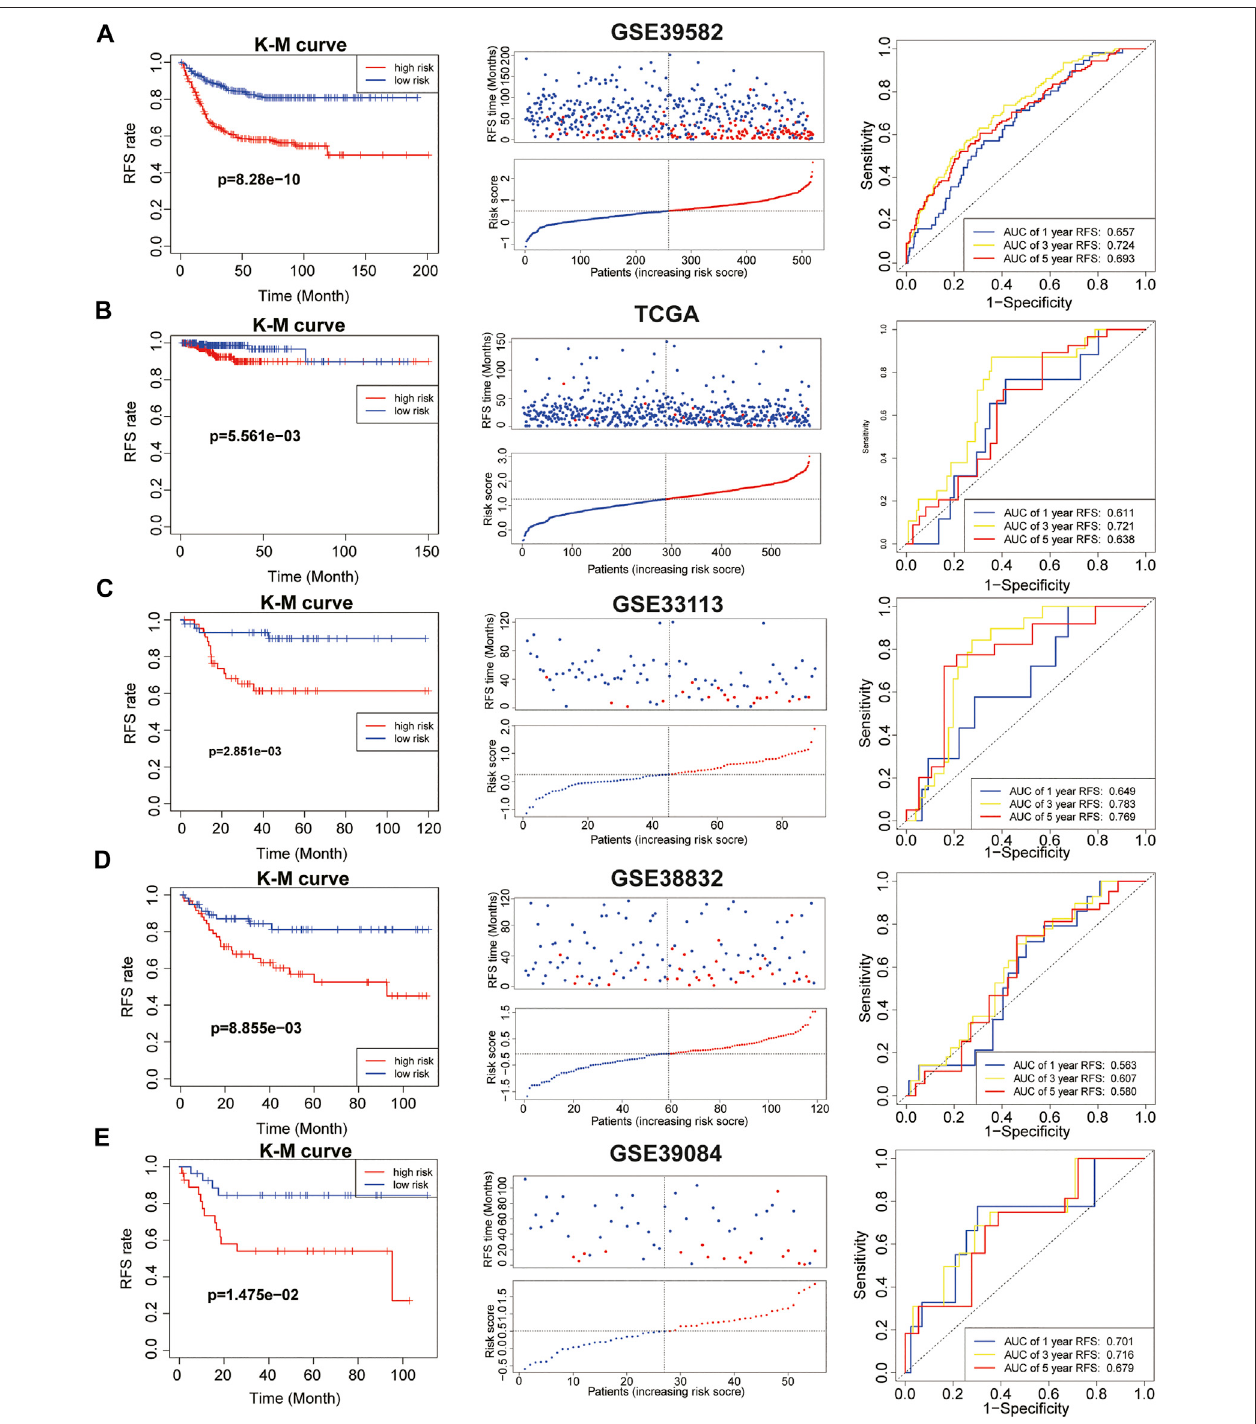
FIGURE3| Immuneevasion-relatedgenessignature(IEVSig)wasassociatedwithCCsurvival. (A – E) Kaplan – Meiercurvesofrecurrence-freesurvivalaccordingto IEVSig, CC patients ’ distribution plots, and time-dependent receiver operator characteristic curves of IEVSig in the GSE39582 training cohort (A) , the Cancer Genome Atlas cohort (B) , GSE33113 (C) , GSE38832 (D) , and GSE39084 (E) .